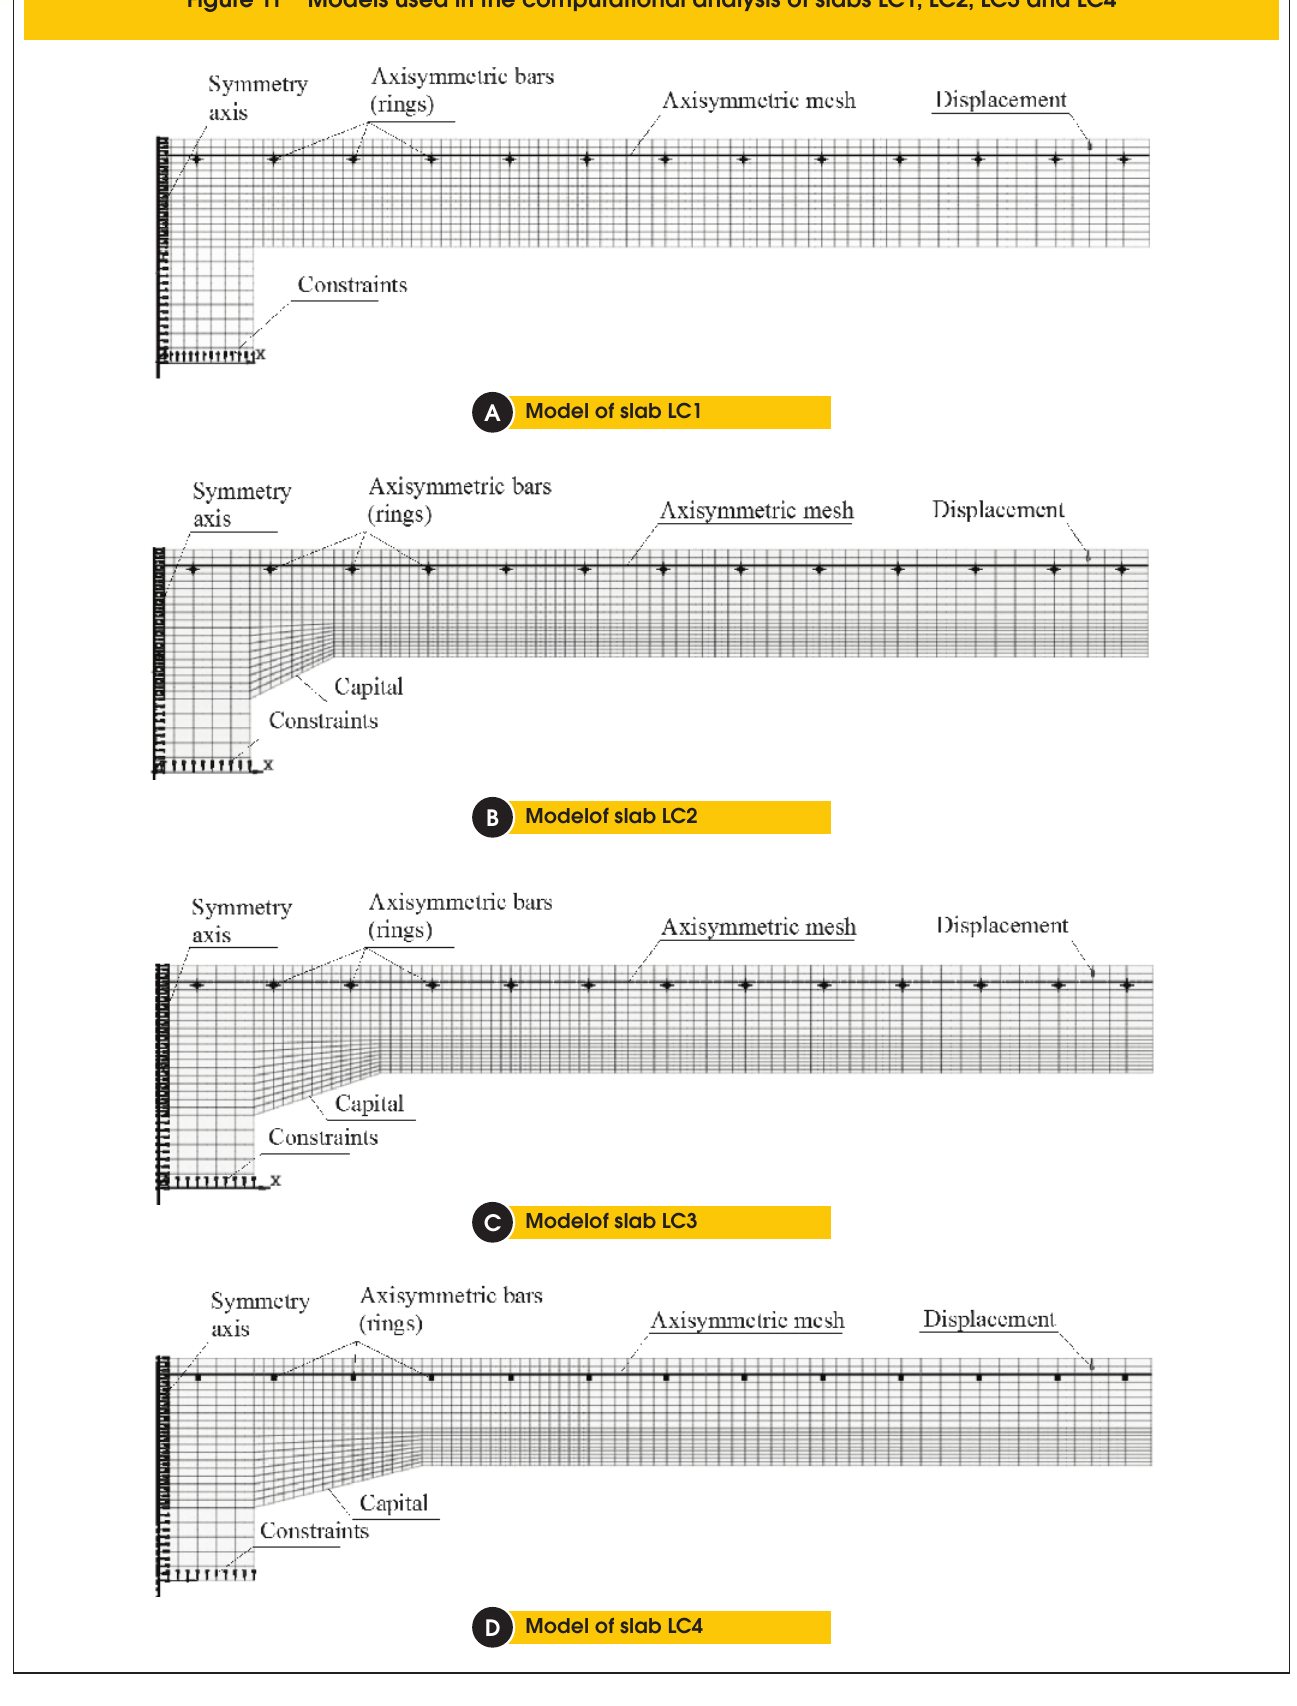
Figure 11 – Models used in the computational analysis of slabs LC1, LC2, LC3 and